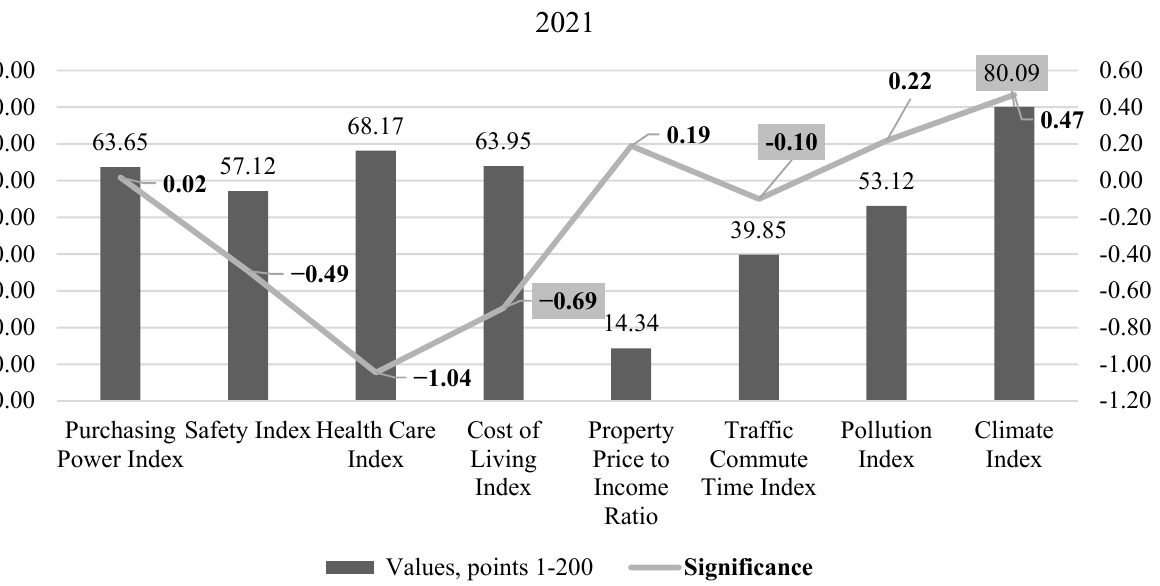
Figure 4. Arithmetic means of the indicators of quality of life and their regressive connection with smart cities in 2021. Source: calculated and built by the authors.